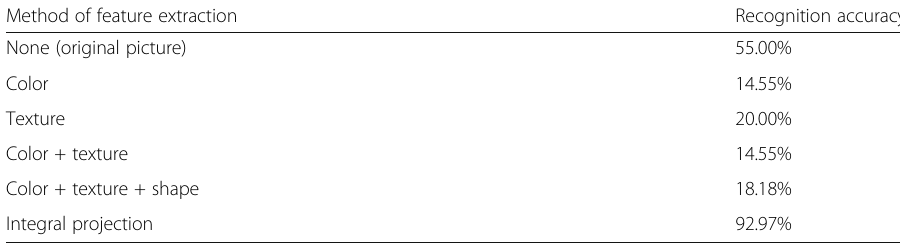
Table 3 The recognition accuracy using different methods of feature extraction in SOP-Boost Method of feature extraction